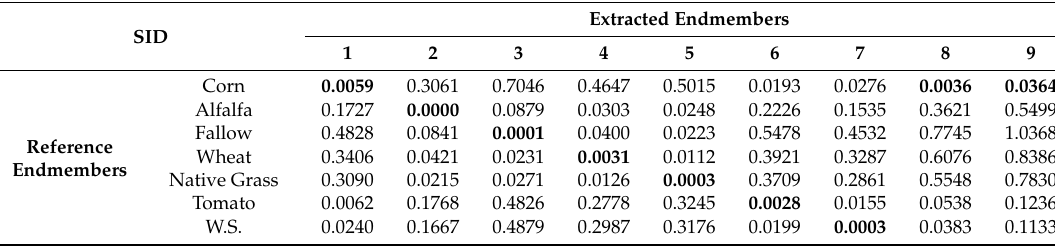
Table 5. Similarity values among the extracted endmembers and the reference spectral signatures of each endmembers by spectral information divergence (SID).